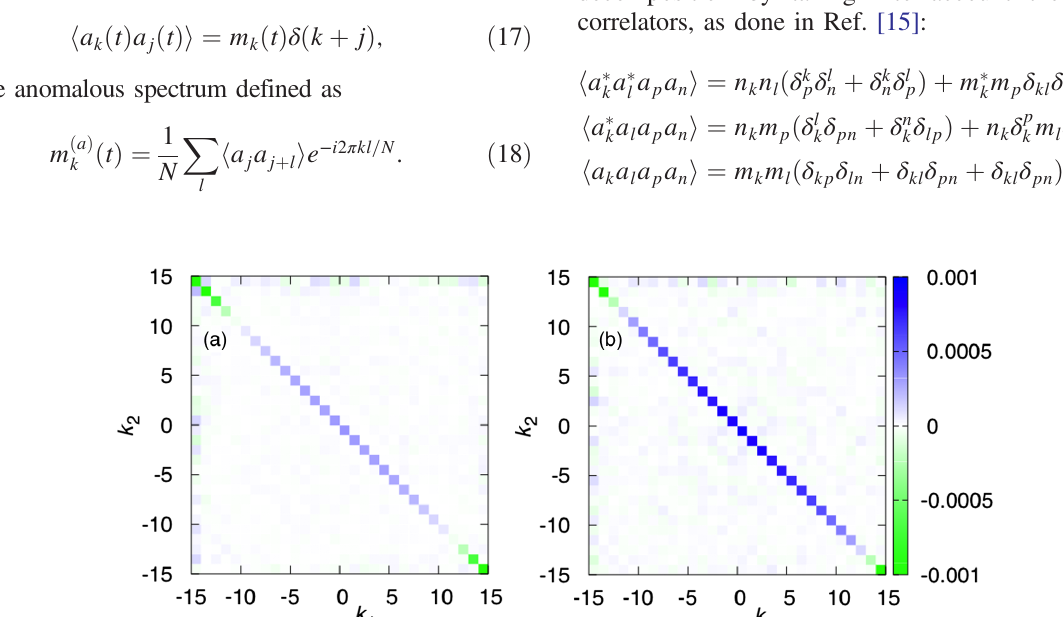
FIG. 3. The real part of the second-order anomalous correlator, Re ½h a k corresponding to k 2 ¼ − k 1 is evident in both panels. As the nonlinearity is increased, the contribution becomes